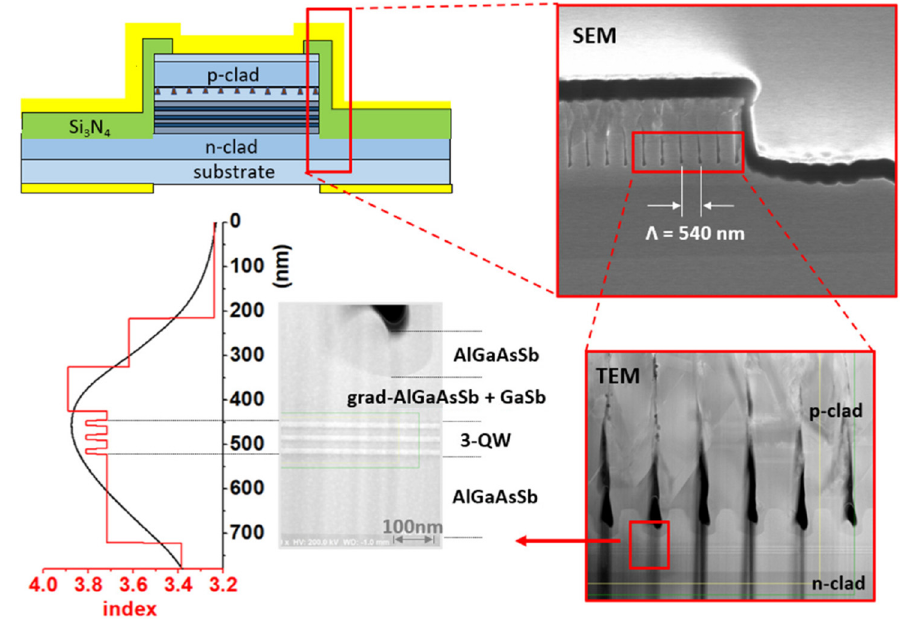
Figure 1. Tope left: Schematic cross-section of the substrate outcoupled etched mesa PCSEL. Top right: Cross-section SEM image of the PCSEL cleaved through the mesa. Bottom right: Cross-section TEM image of the regrowth interface containing air-pockets. Bottom right: Magnified TEM image of the active region overlapped with the corresponding calculated index profile and laser fundamental mode.